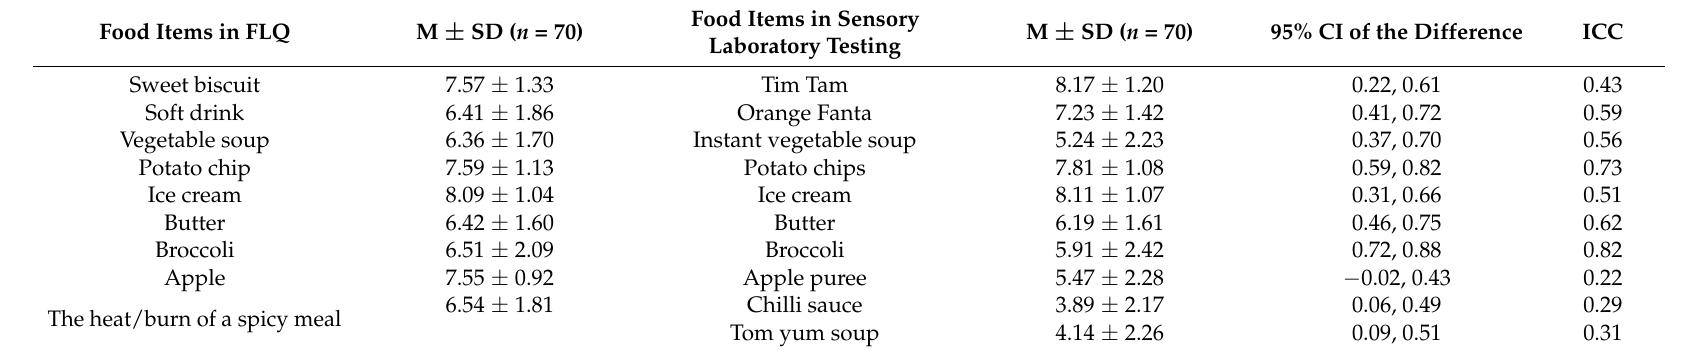
Table 4. Comparing mean score and reliability (ICC) between food liking questionnaire and laboratory-based liking assessment. Food Items in